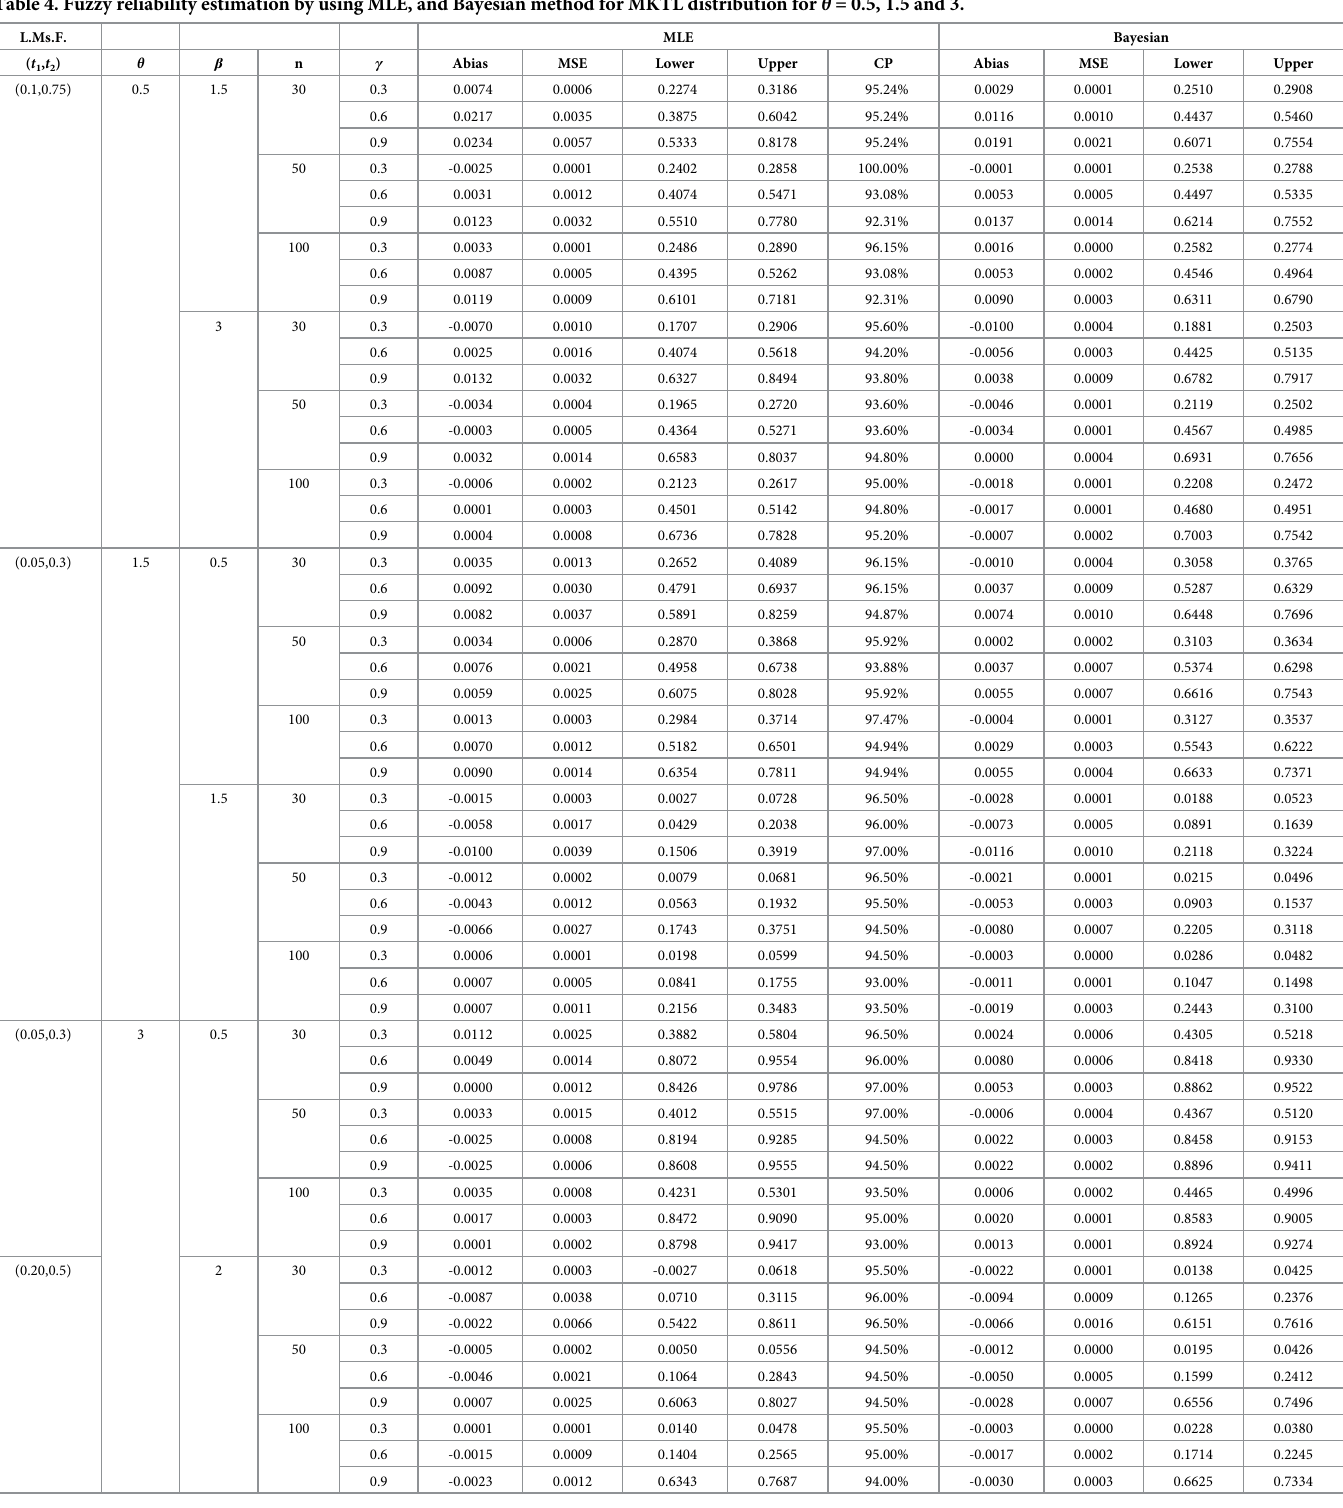
Table 4. Fuzzy reliability estimation by using MLE, and Bayesian method for MKTL distribution for θ = 0.5, 1.5 and 3.